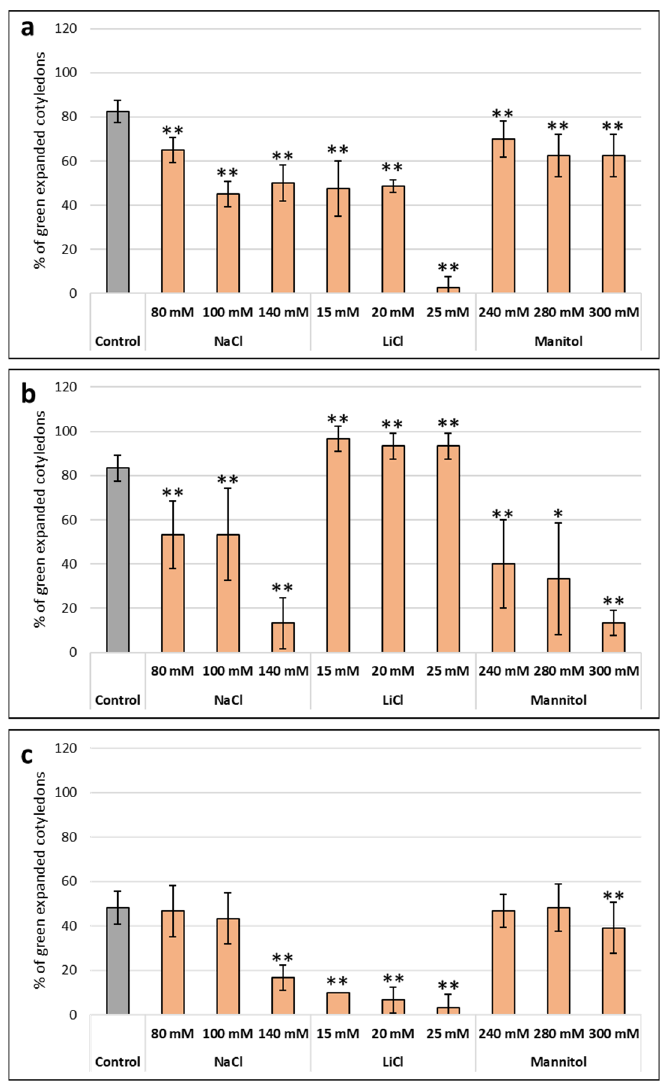
Figure 2. Evaluation of the effect of different concentrations of NaCl, LiCl and mannitol on the seed germination of ( a ) broccoli, ( b ) tomato and ( c ) lettuce. The X-axis indicates control without stress (gray) or the different concentrations of abiotic stressors (orange), while the Y-axis represents the percentage of expanded green cotyledons. The bars represent a standard error. * p < 0.05 by Student’s tests for increased germination compared to the control; ** p < 0.01 by Student’s tests for increased germination compared to the